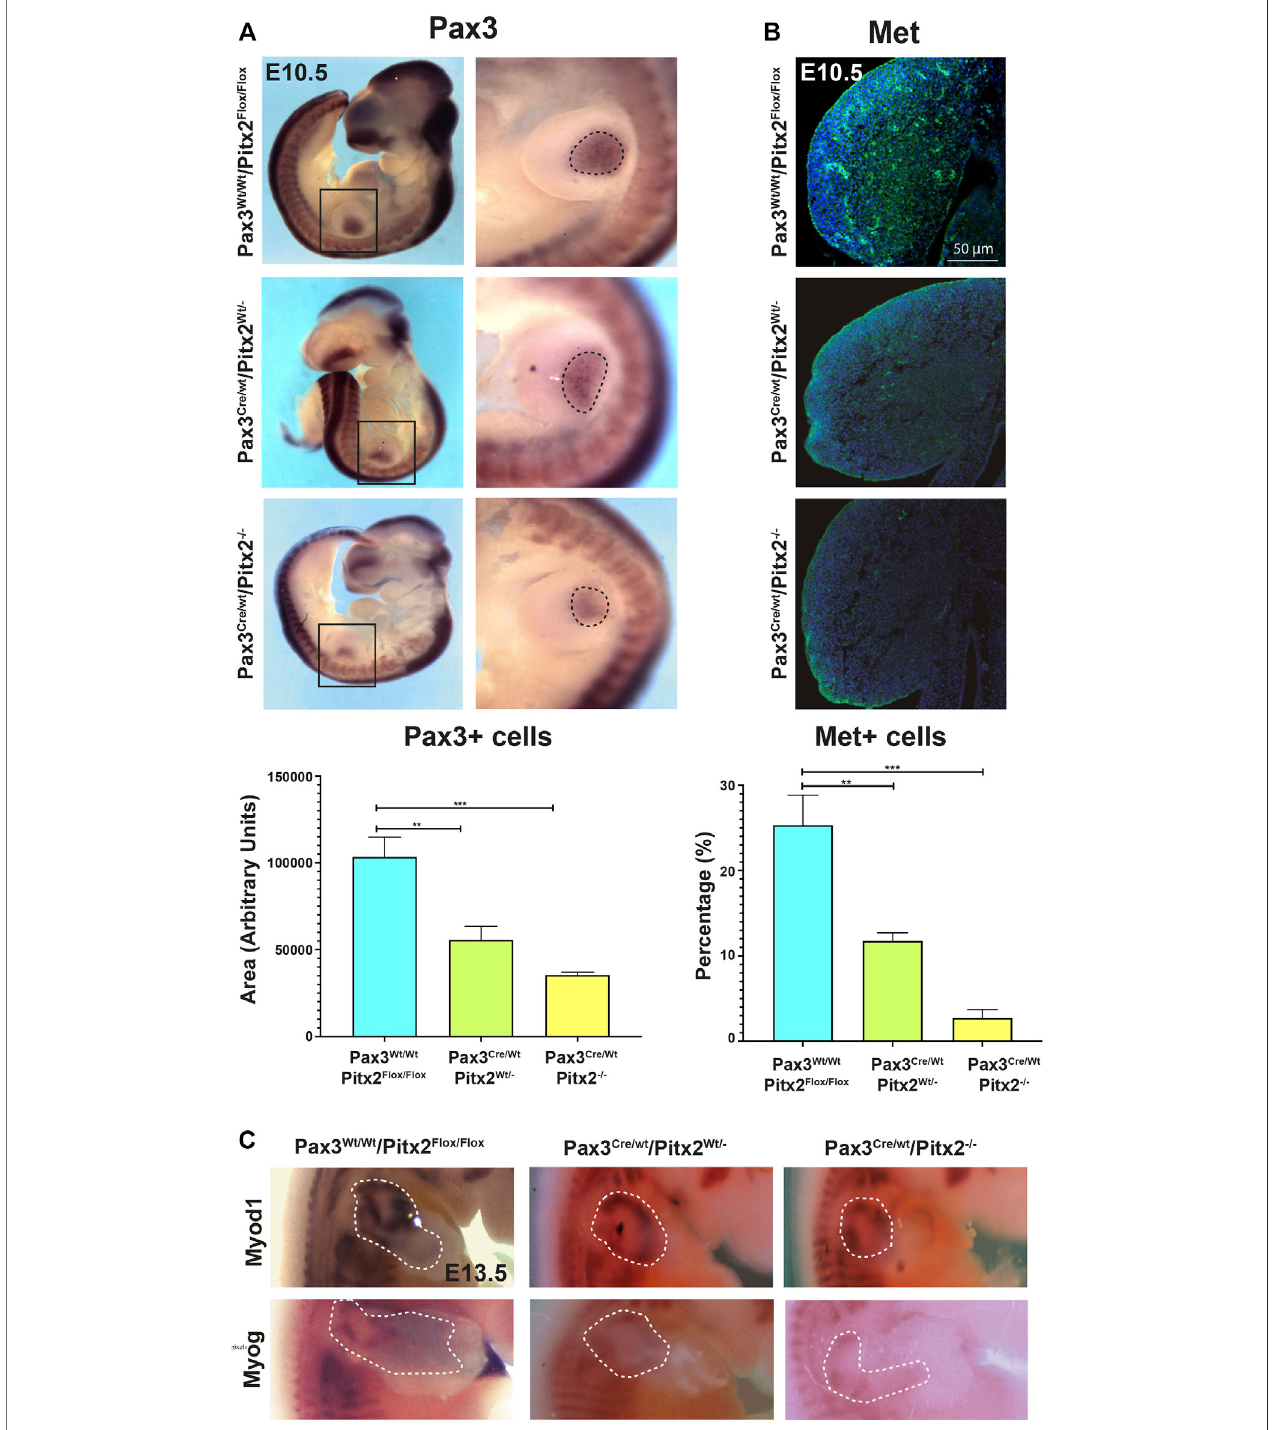
FIGURE 2 | Cell migration of Pax3 + precursors is reduced in Pax3 Cre/Wt Pitx2 − / − conditional mutant embryos. (A) Representative images of in situ hybridization for Pax3 inPax3 Wt/Wt /Pitx2 Flox/Flox ,Pax3 Cre/Wt Pitx2 Wt/- andPax3 Cre/Wt Pitx2 − / − embryosatE10.5.Pax3 + cellsinthelimbbudsaredotted.Quanti fi cationoftheareaof Pax3 - expressingcells in the limb buds ofPax3 Cre/Wt Pitx2 − / − conditional mutant embryos is shown. (B) Representative images and its magni fi cation ofimmunohistochemistry forc-METinPax3 Wt/Wt /Pitx2 Flox/Flox ,Pax3 Cre/Wt Pitx2 Wt/- andPax3 Cre/Wt Pitx2 − / − embryosatE10.5.Quanti fi cationofthenumberofcMET + cellswithrespecttototal nuclei in the limb buds of Pax3 Cre/Wt Pitx2 − / − conditional mutant embryos is shown. (C) Representative images of in situ hybridization for Myod1 and Myog in Pax3Cre Wt/Wt /Pitx2 Flox/Flox ,Pax3 Cre/Wt /Pitx2 Wt/- andPax3 Cre/Wt /Pitx2 − / − atE13.5stage. Myod1 and Myog expresionzonesinthelimbbudsaredotted.** p < 0.01,*** p < 0.001 ( n = at least 3 embryos per condition).